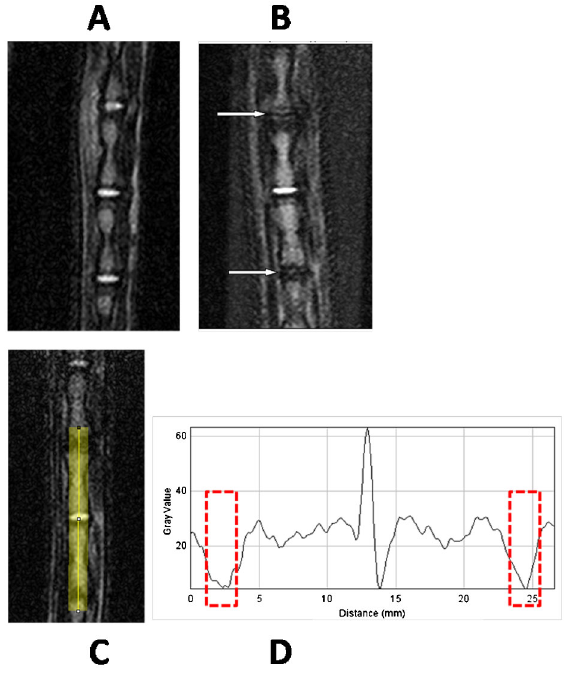
Figure 2. Radiographic assessment of intervertebral disc degeneration. A , Radiographic images were taken using a radiopaque scale with millimeter markings to recognize the intervertebral disc level of interest. Arrows indicate punctured intervertebral discs. B , Using digitized radiographs, measure- ments including the proximal (PV) and distal (DV) vertebral body height and intervertebral disc height (DH) were analyzed using the public domain image analysis program developed by the U.S. National Institutes of Health - ImageJ (http://imagej.nih.gov/ij/). 1 = anterior; 2 = middle; 3 =